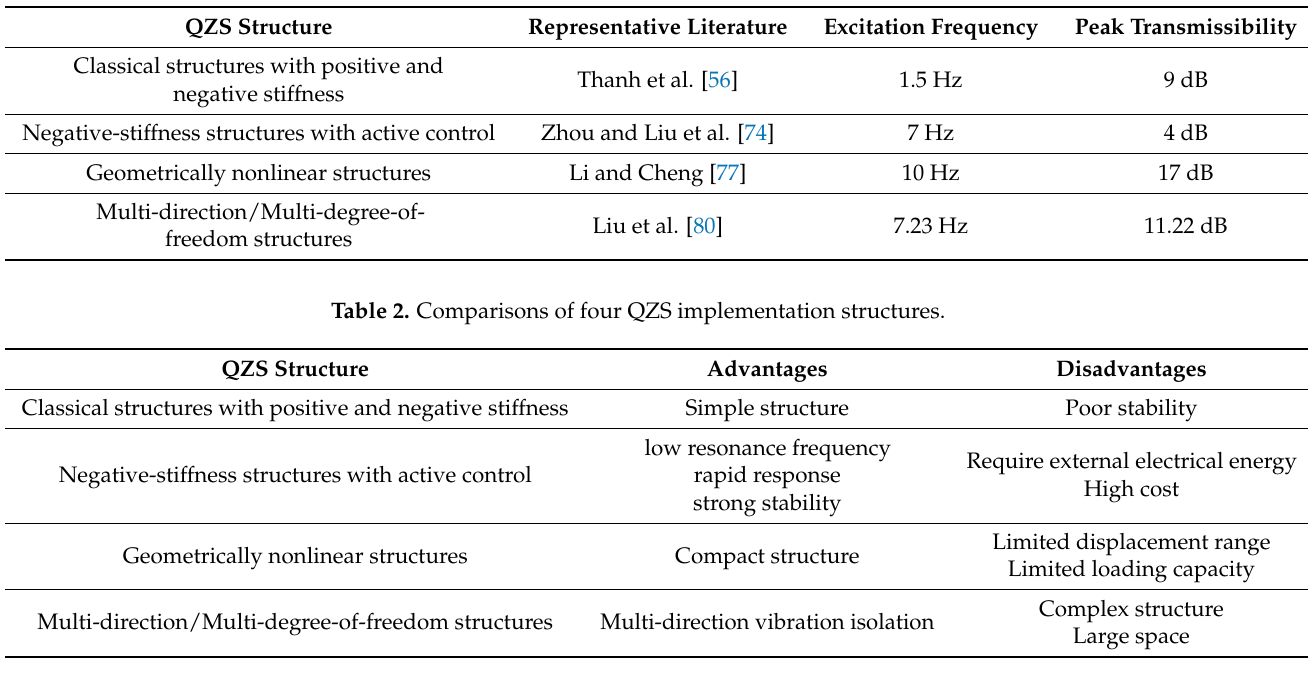
Table 1. Comparisons of four QZS implementation structures.